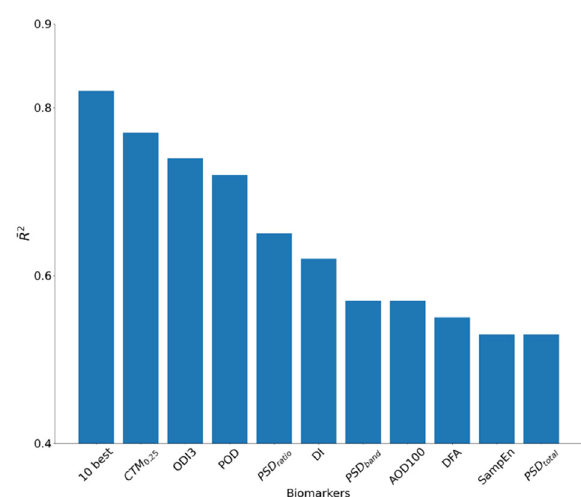
Fig. 2 Linear correlation between oximetry biomarkers and the AHI. The adjusted R 2 is reported for every biomarker and for the 10 biomarkers with the highest R 2 .